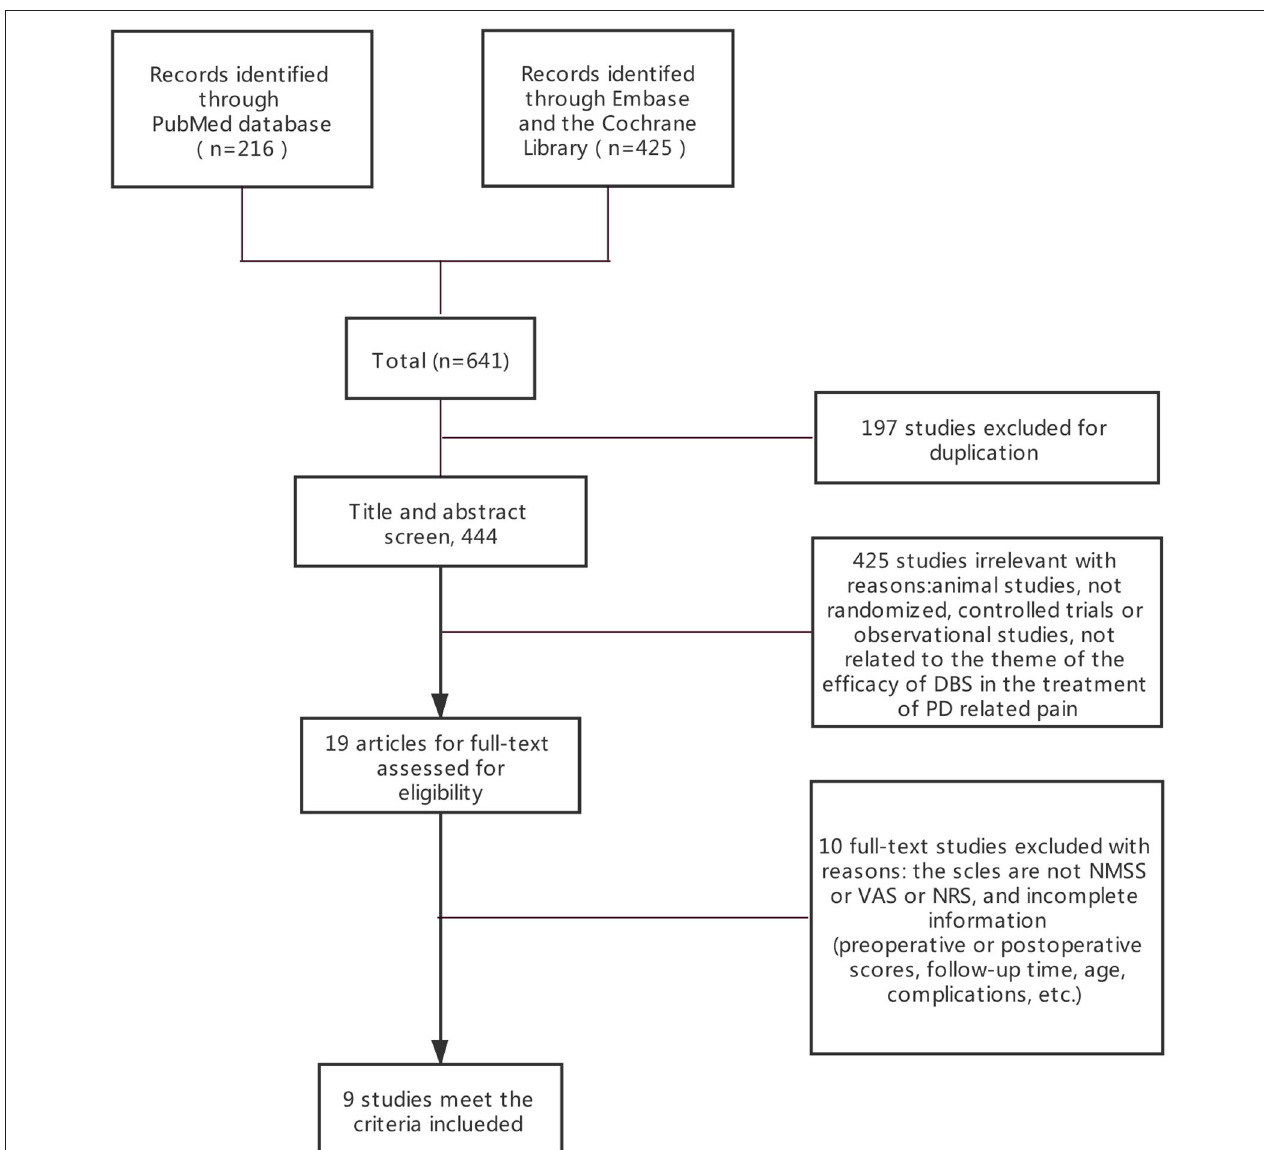
FIGURE 1 | PRISMA flowchart: A flowchart ultimately showing the included studies. PRISMA, preferred reporting items for systematic reviews, and meta-analyses.